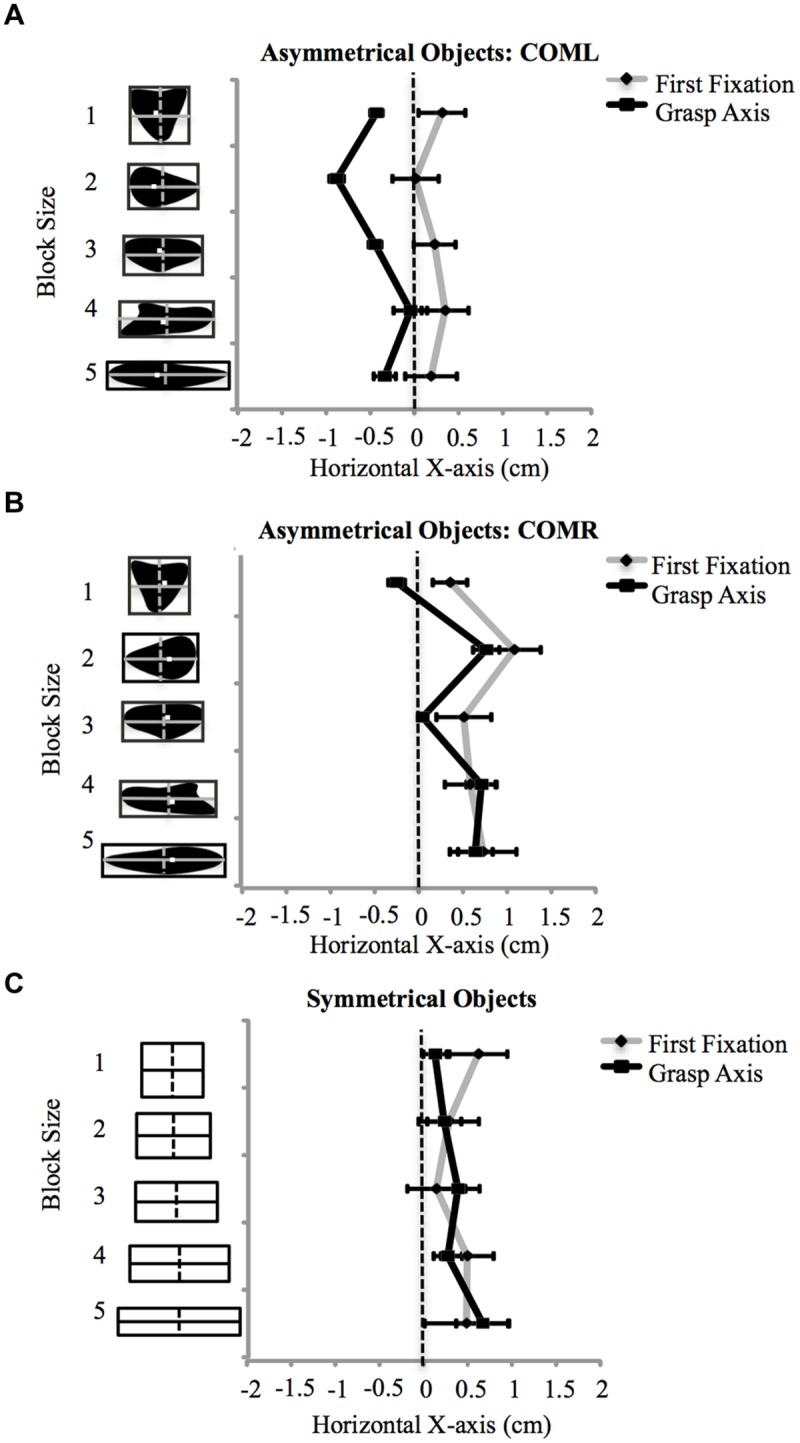
Displays first fixation and grasp axis locations along the X-axis (cm) across object size for each object group separately in Experiment 1: (A) COML, (B) COMR, (C) symmetrical objects. Negative values represent fixation locations to the left of the object’s horizontal center. Error bars represent the standard error of the mean. The COM location for each asymmetrical object is represented by a white square on the object.